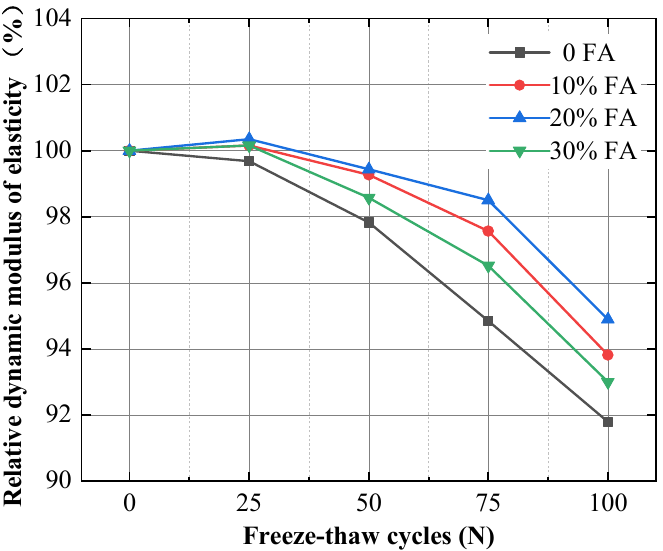
Figure 5. RDEM of concrete specimens.